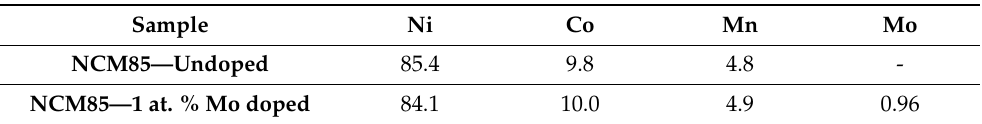
Table 1. Chemical composition (in at. %) of NCM85 undoped and Mo-doped materials measured after their synthesis and annealing at 760 ◦ C under pure oxygen for 6